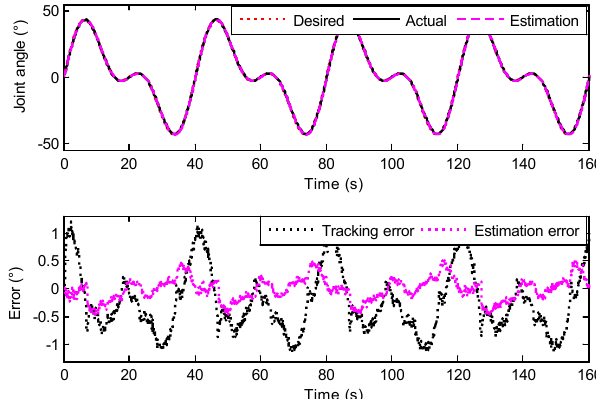
Figure 12. The performance the control block diagram with a joint angle estimator.